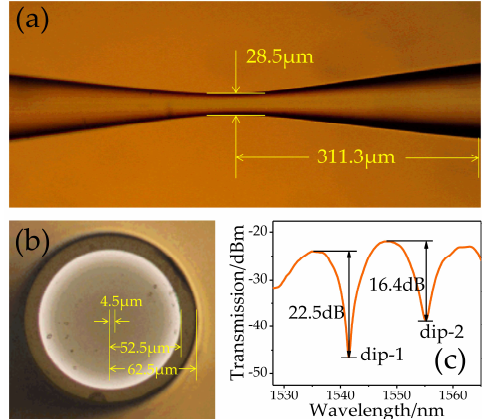
Figure 2. ( a ) Microscope image of the fabricated taper. ( b ) The cross-sectional morphology of double-cladding fiber (DCF). ( c ) The transmission spectrum of the single-pass (SP) structure.